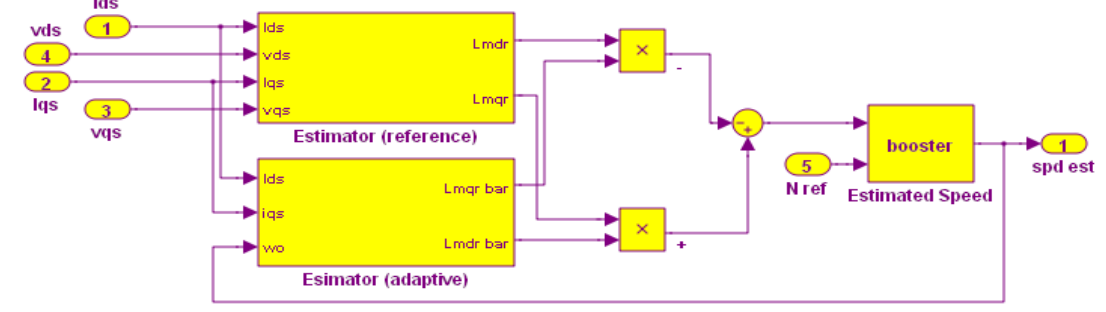
Figure 5. Simulink implementation